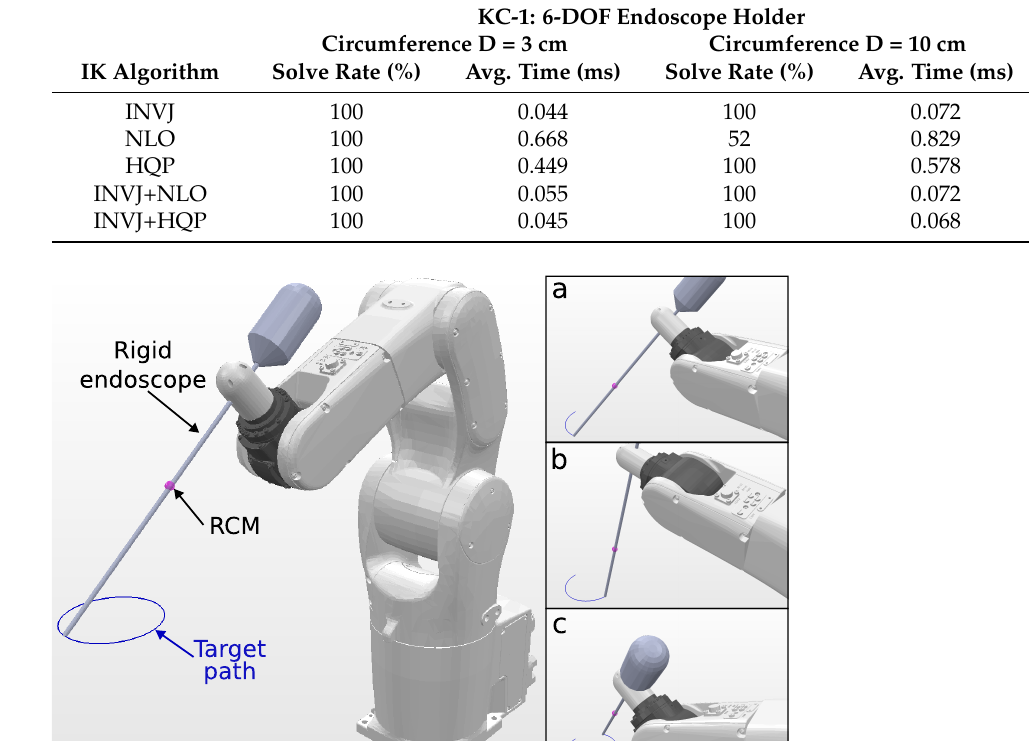
Table 4. A comparison of the solve rate and the solving time for single-method and concurrent IK algorithms. The target trajectories are two circular paths with diameters of 3 cm and 10 cm. Evaluation is performed for the KC-1 kinematic chain (endoscope holder).